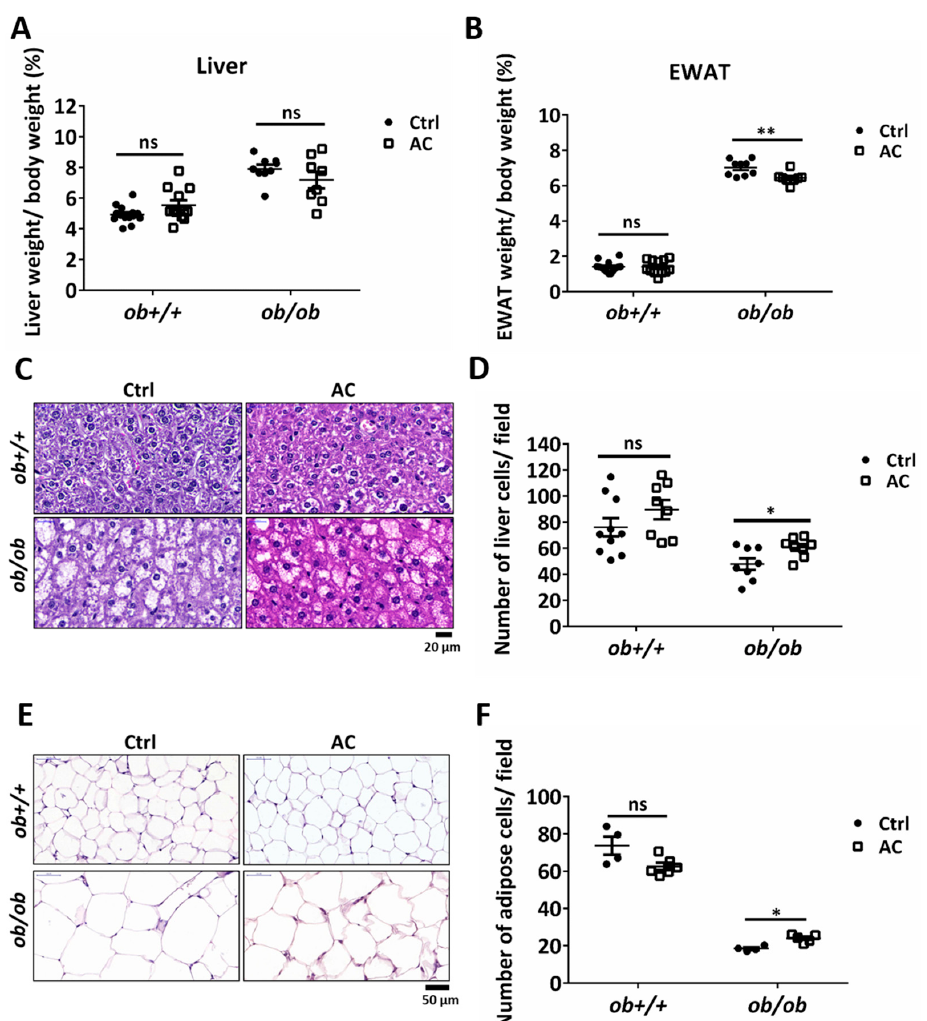
Figure 2. AC may suppress lipid accumulation and deposition in the liver and EWAT in ob / ob mice. ( A , B ) Percentage of liver or epididymal white adipose tissue (EWAT) weight were normalized to body weight after ob +/+ and ob / ob mice were fed with or without AC for 4 weeks. ( C , E ) The liver and EWAT were examined using hematoxylin and eosin staining. ( D , F ) The number of liver or EWAT cells per field was estimated using the ImageJ software. Magnification, 100 × . Scale bars are 20 µ m for the liver and 50 µ m for EWAT. All data are expressed as mean ± SEM, * p < 0.05, ** p < 0.01, *** p < 0.001. Non-significant; ns. n = 4–14 mice in each group.